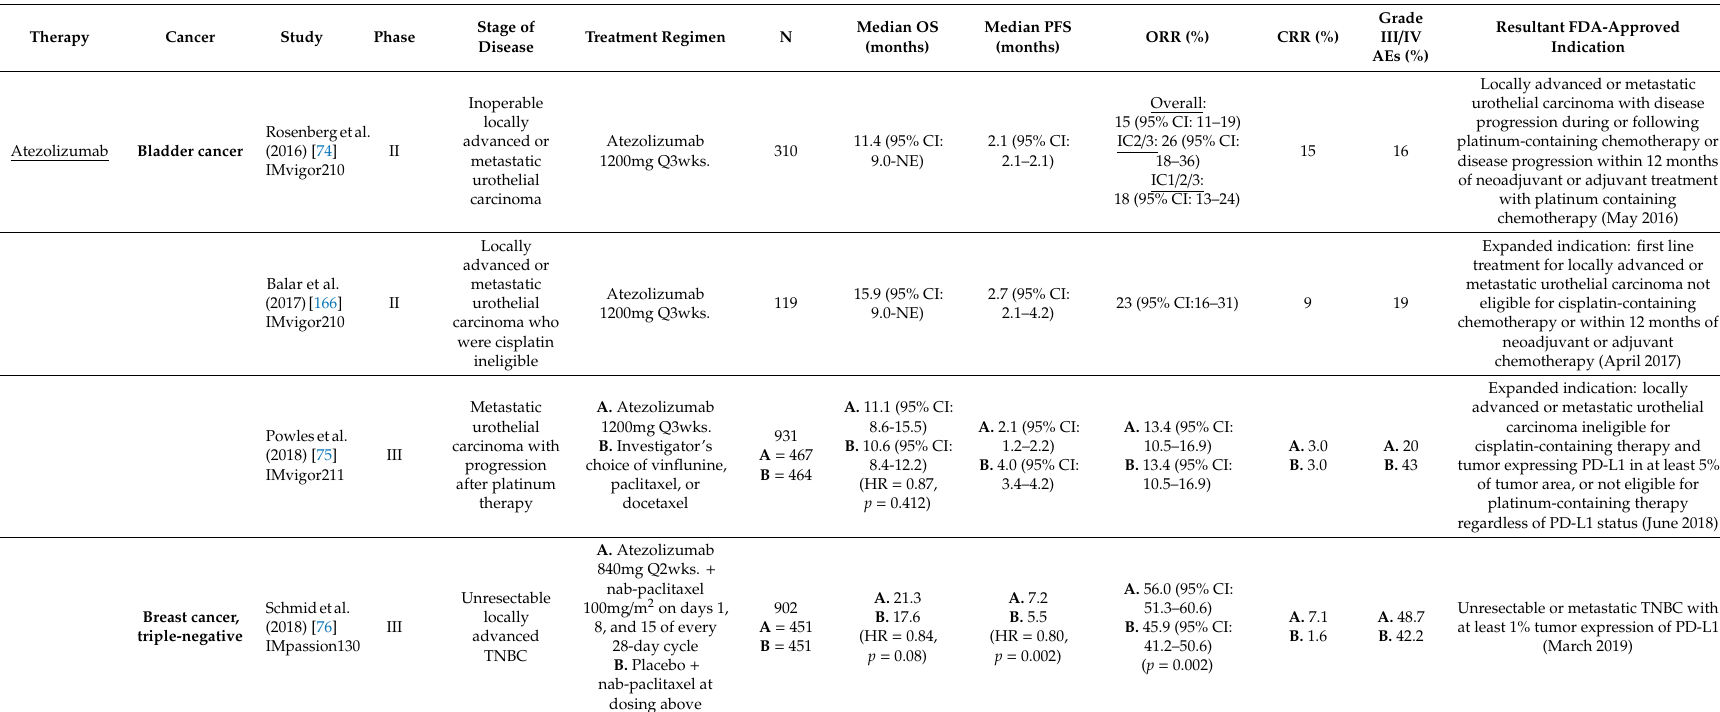
Table A5. Clinical data for PD-L1